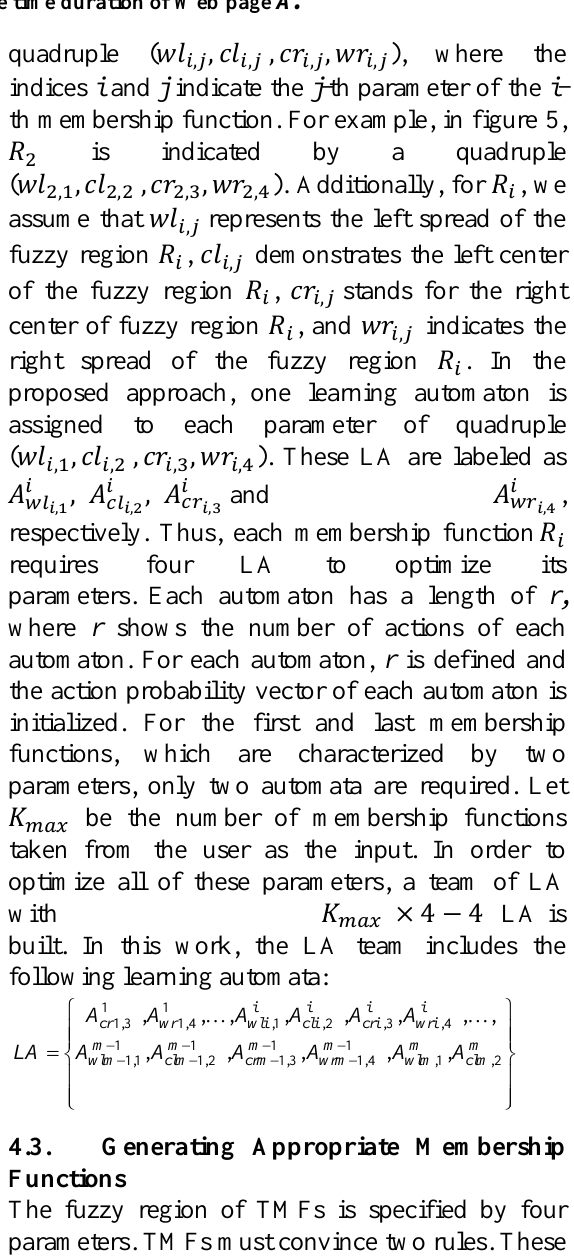
Figure 3. Membership functions for the time duration of Web page